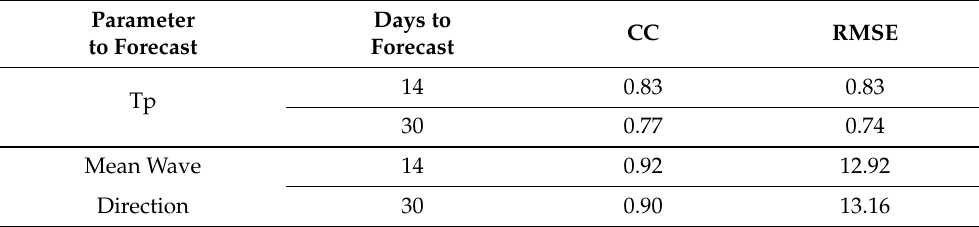
Table 6. Results of the prediction of the peak wave period (Tp) and the mean wave direction using the BiLSTM